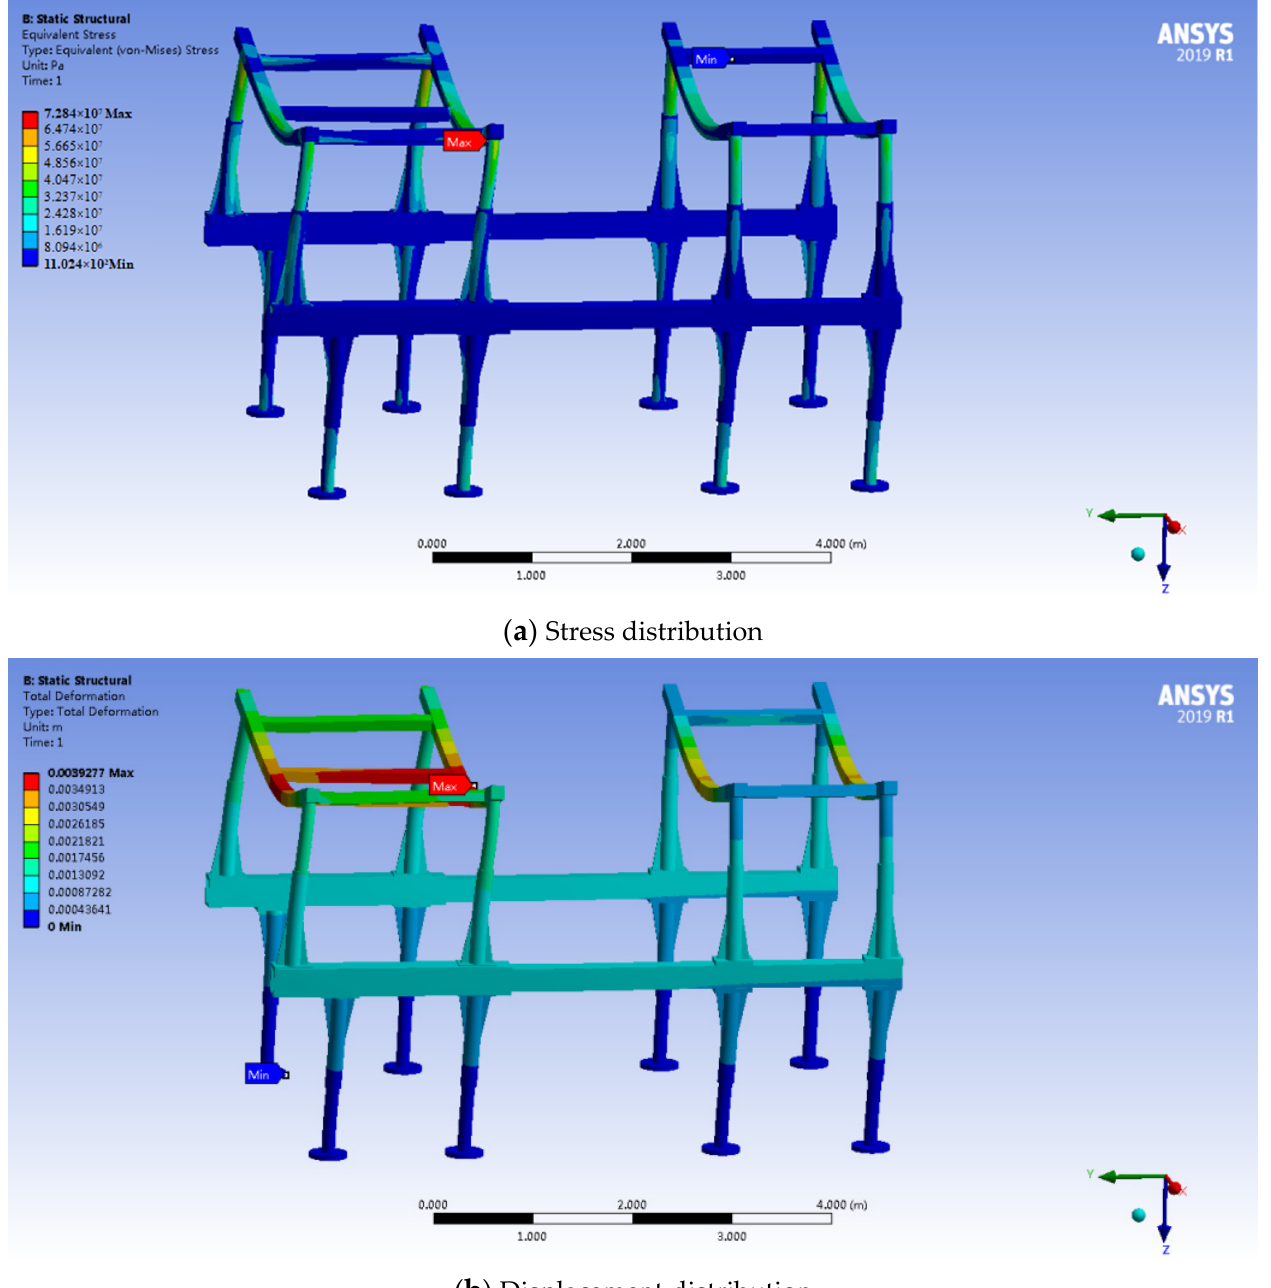
Figure 6. Stress and displacement distribution of the advance support under the lateral external- force interference.